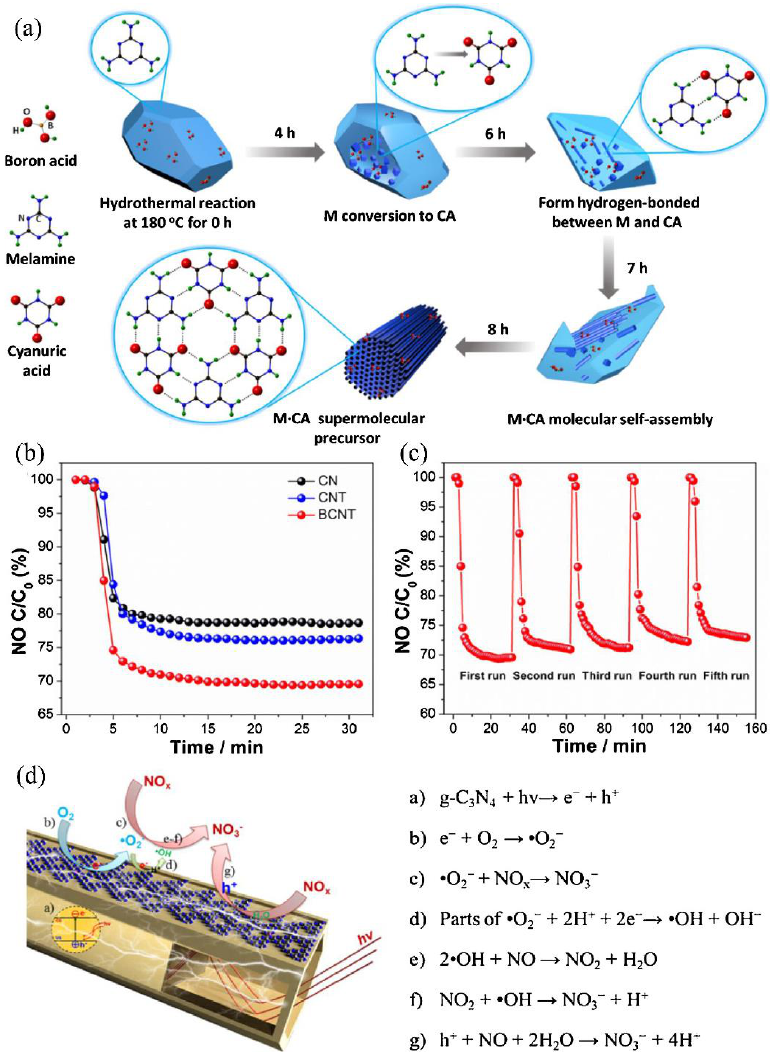
Figure 9. ( a ) Schematic illustration for the preparation of B − doped g − C 3 N 4 hollow tubes. ( b ) Photo- catalytic performance of bulk g − C 3 N 4 , g − C 3 N 4 tubes and B − doped g − C 3 N 4 tubes for the removal of